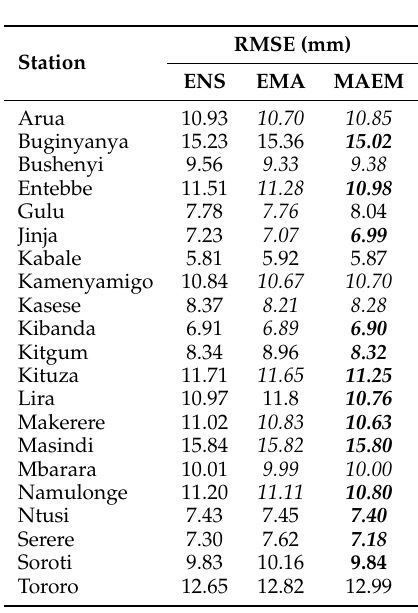
Table 3. Shows the RMSE for: ensemble mean (ENS); ensemble mean analogue (EMA) and multi–member analogue ensemble (MAEM). The italicized values show improvement in the RMSE of the EMA and the RMSE of the MAEM compared to the RMSE of the ENS. The bold values in the 4th column show a reduction in RMSE using MAEM compared to the RMSE of EMA.